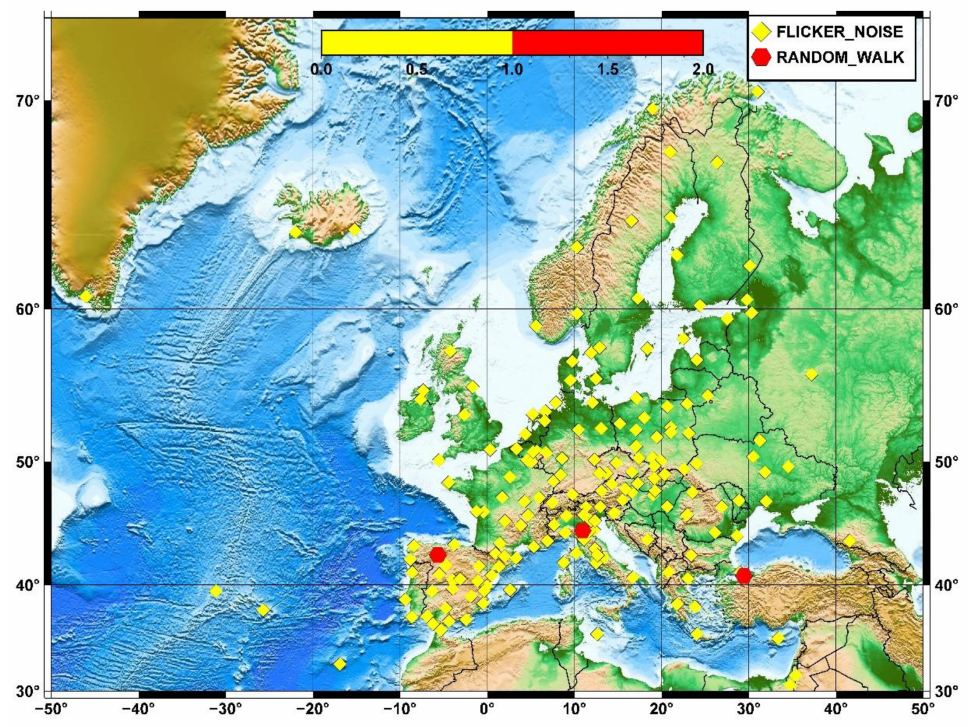
Figure 1. Stations with flicker and randomwalk noise mode for the North and East